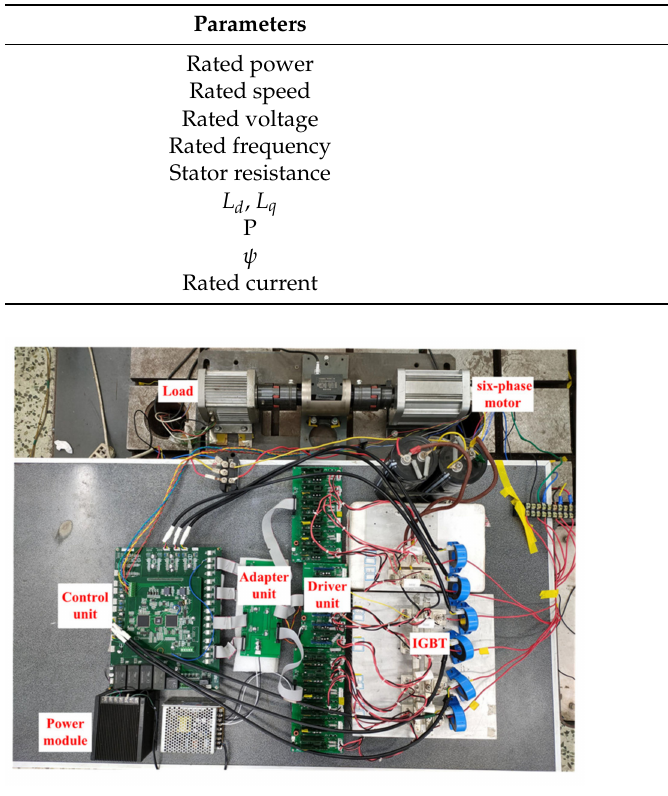
Figure 25. Experimental